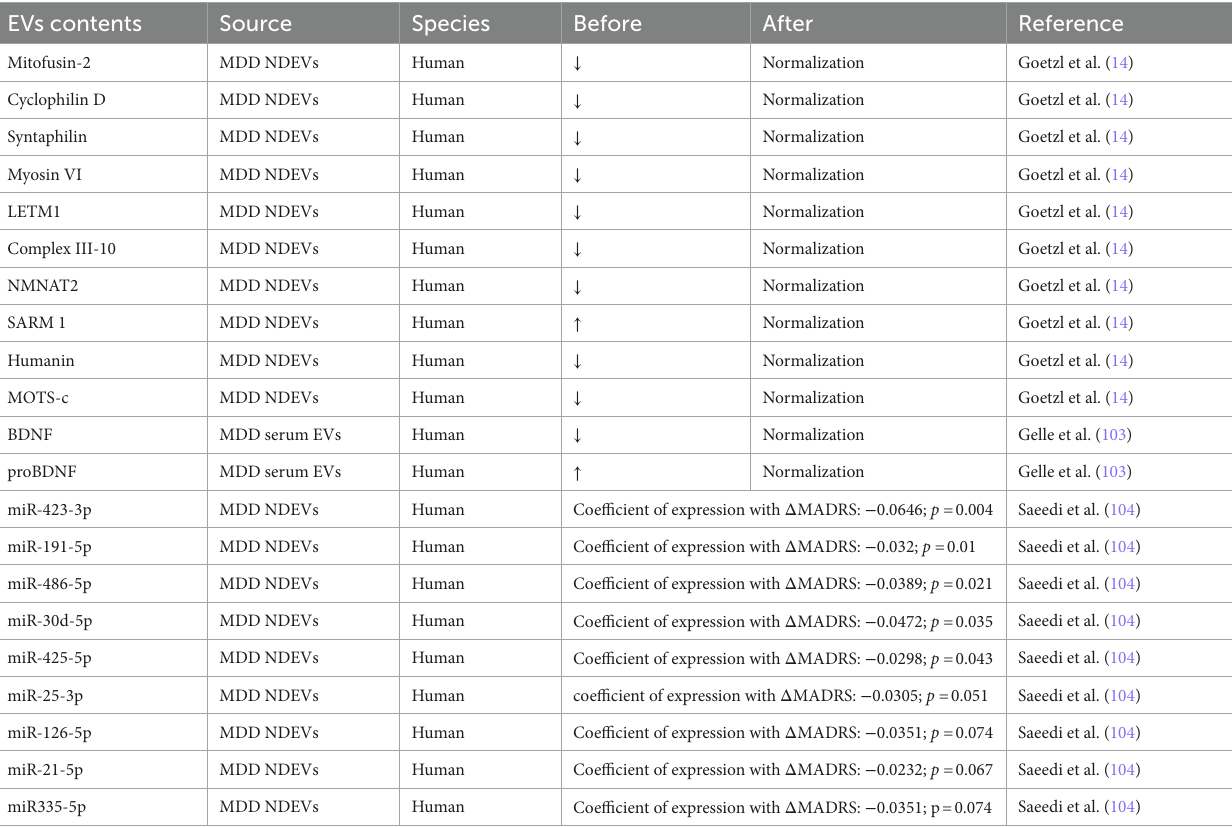
TABLE 2 Changes of proteins in EVs before and after antidepressant